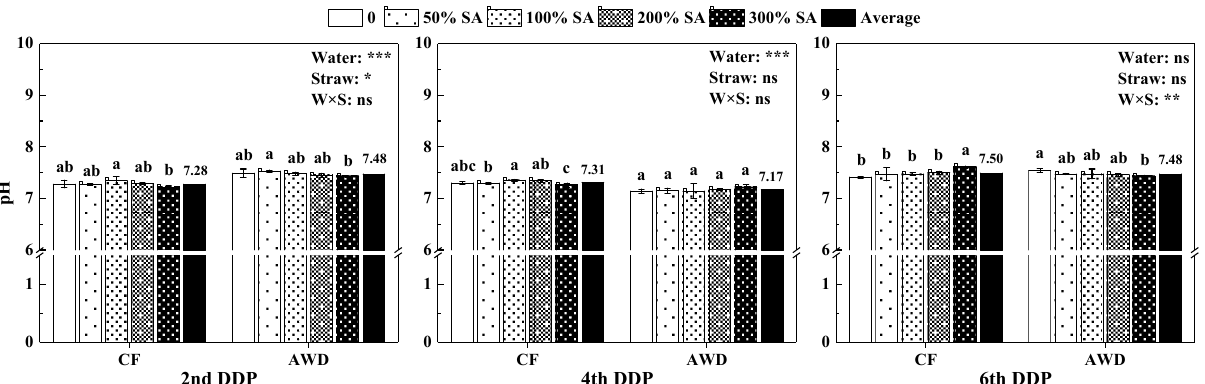
Figure 3. Soil pH under different water management regimes and straw addition rates. Different letters indicate significantly different at p < 0.05 under the same water management regime. Data in the figures indicate means of three replicates ± standard deviation. * means p < 0.05; ** means p < 0.01; *** means p < 0.001; ns means nonsignificant. CF, continuous flooding irrigation; AWD, alternate wetting and drying irrigation; SA, straw addition rate. DDP, day of the drying period.